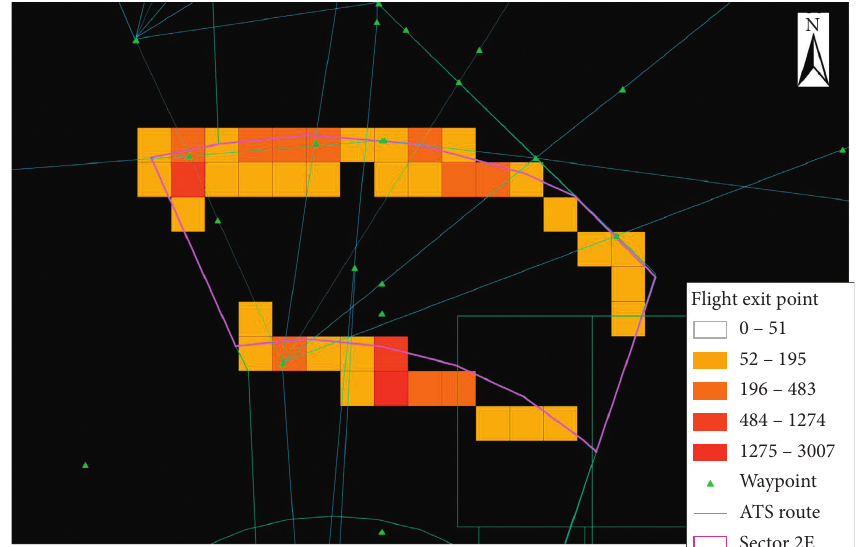
Figure 4: Distribution of exit points in sector